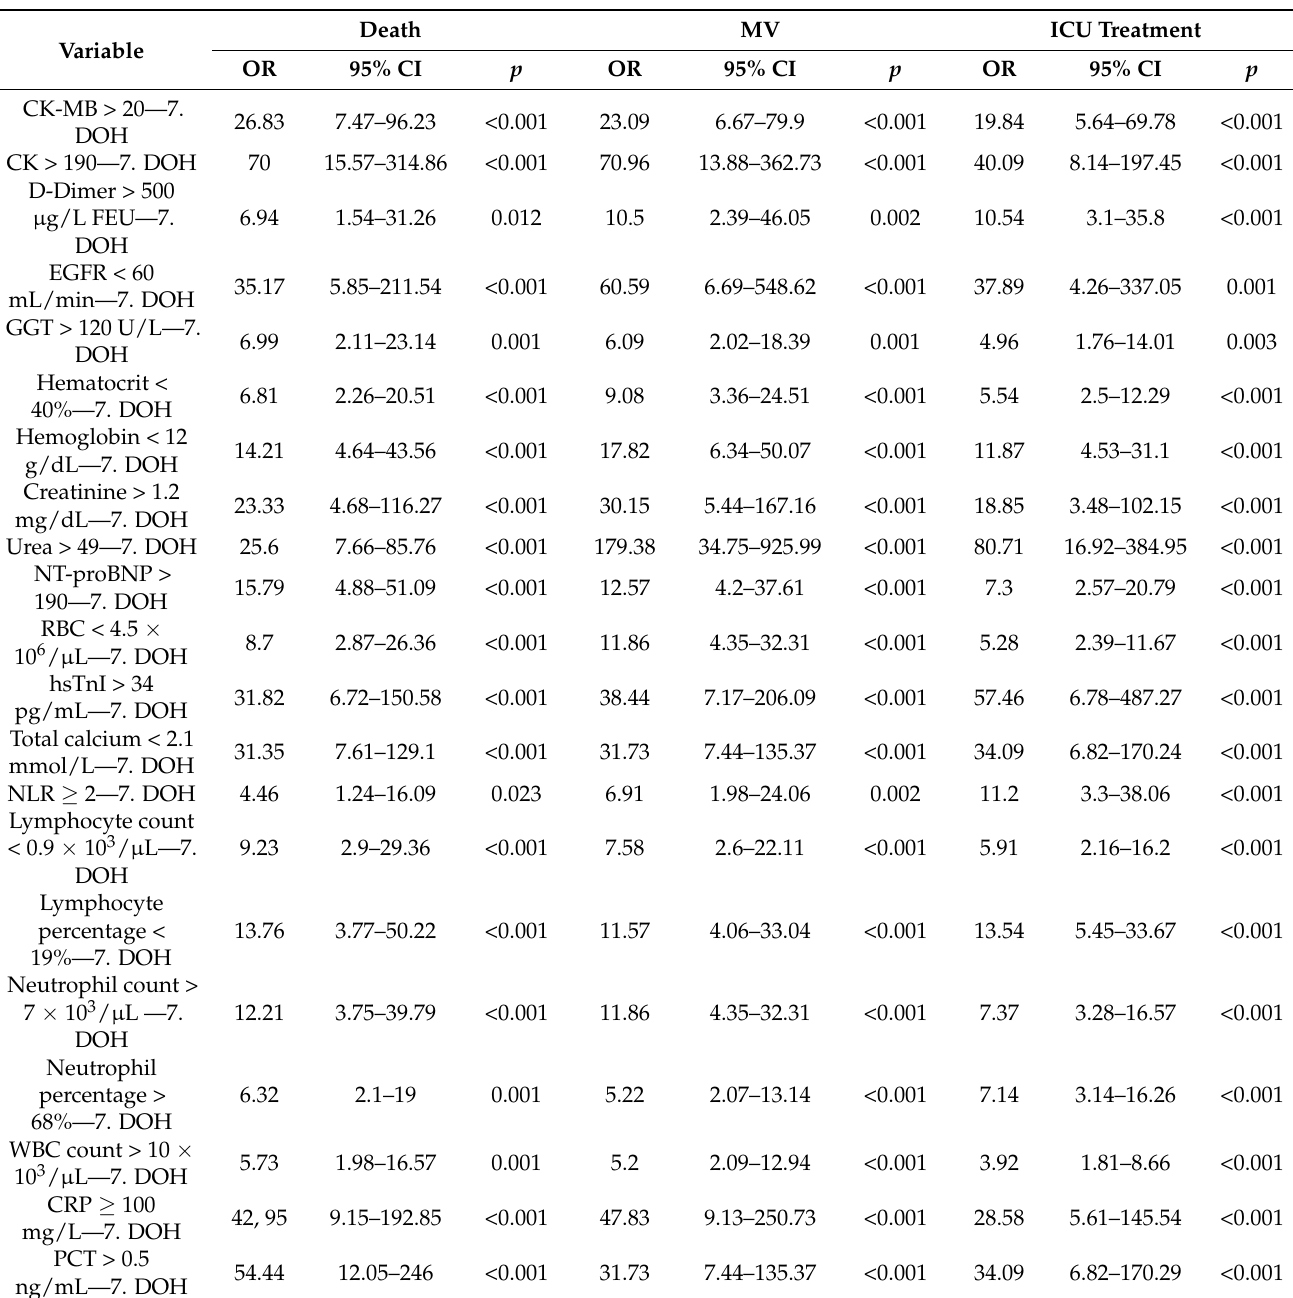
Table 7. Univariate logistic regression analysis of selected laboratory parameters at the 7th DOH for the prediction of death, mechanical ventilation, and ICU